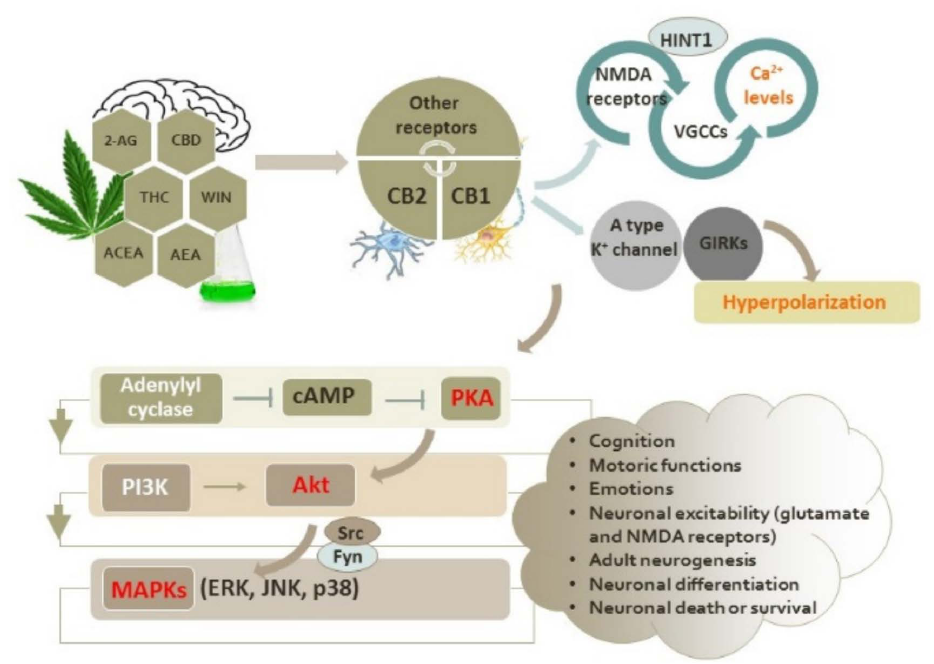
Figure 1. Schematic representation of signaling pathways and downstream targets